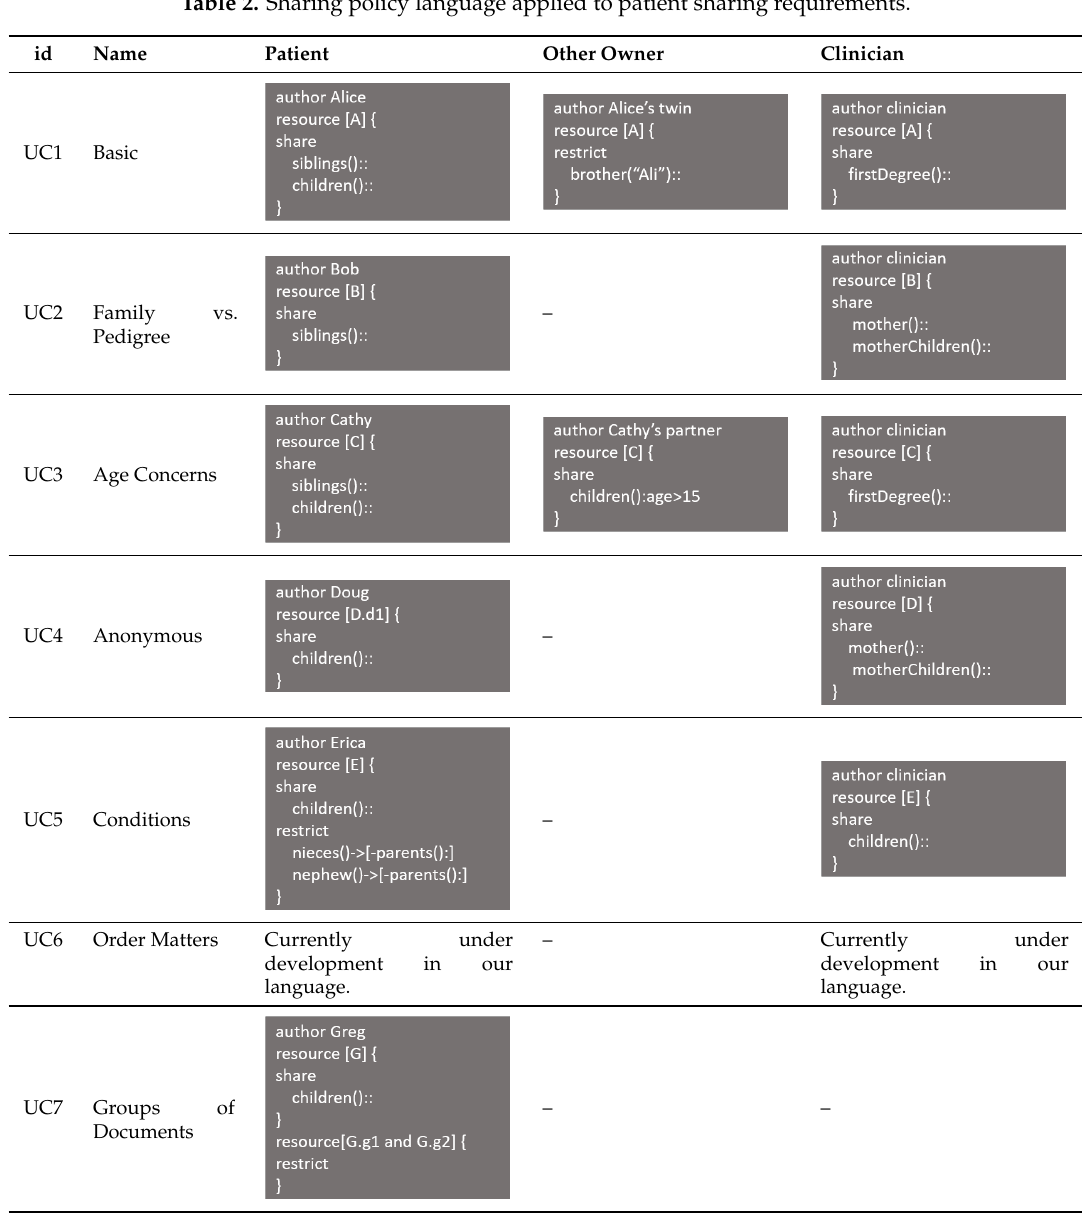
Table 2. Sharing policy language applied to patient sharing